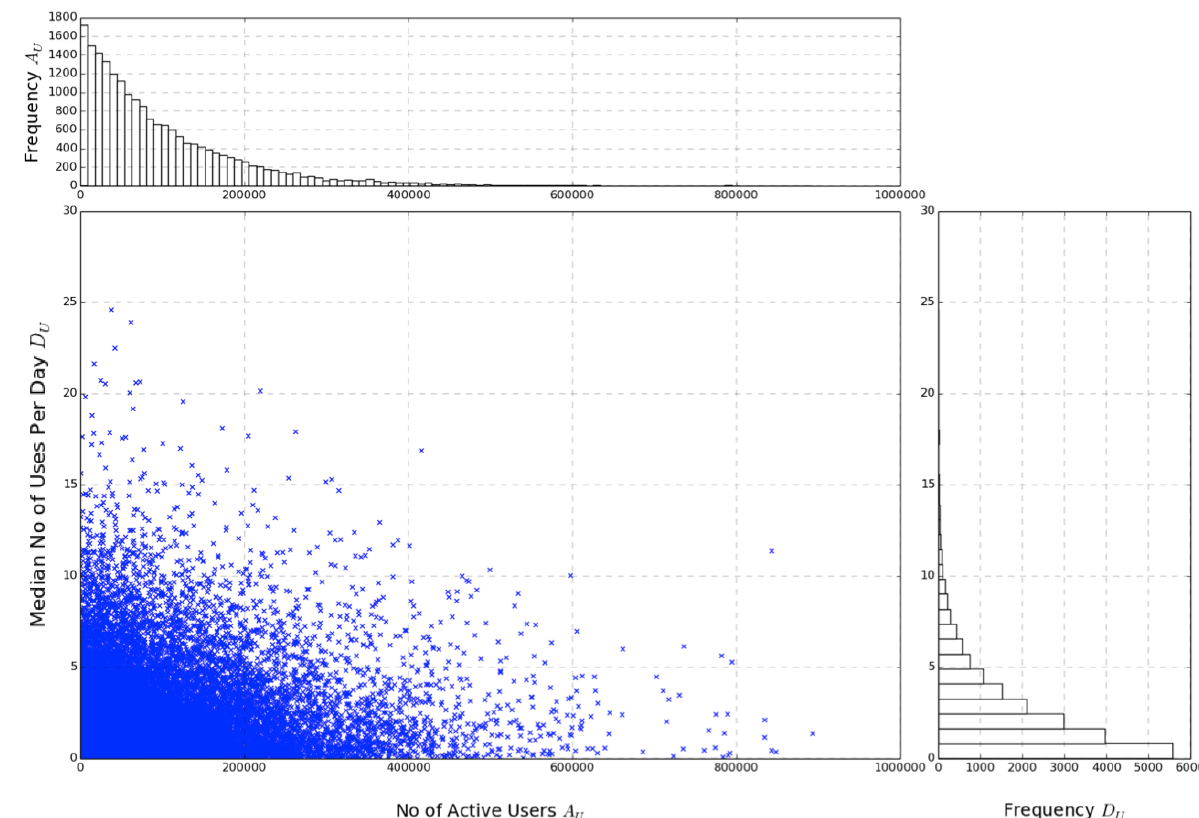
Figure 2. A combined scatterplot (input data, left) and histogram (relative frequency of both Au and Du, right) showing the initial sample dataset of 20,000 mobile medical